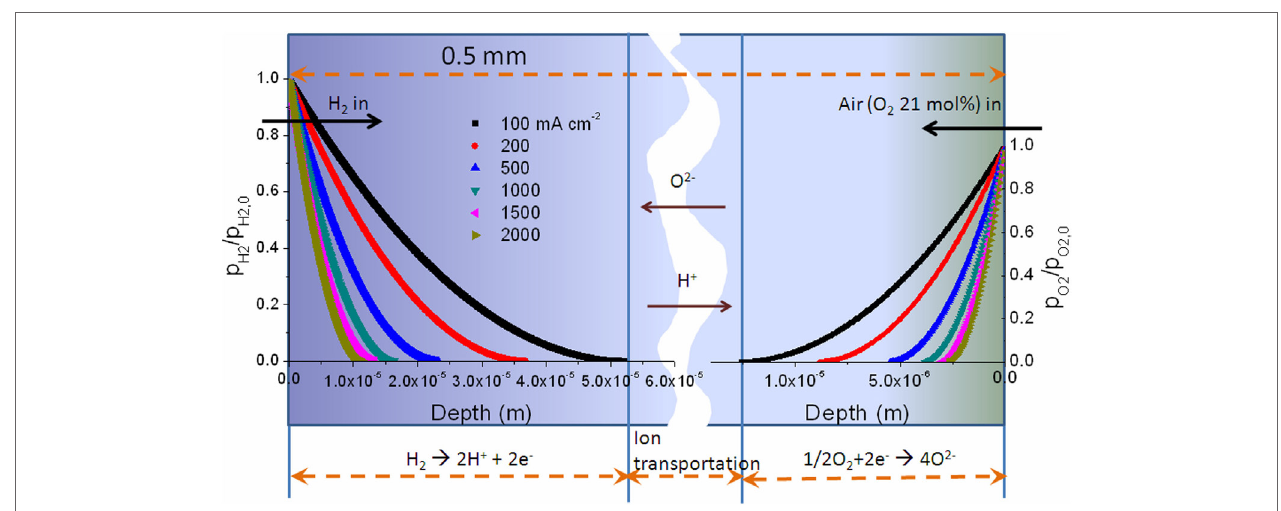
FiGURe 3 | The curve about the depth of fuel side and air side changes, if the current changes under different current conditions; the porosity is equal to 0.5 and the thickness of the single cell is equal to 0.5 × 10 − 3 m . [Permission from Liu et al. (2012). Available from: http://pubs.rsc.org/en/Content/ ArticleLanding/2012/RA/c2ra20694c].